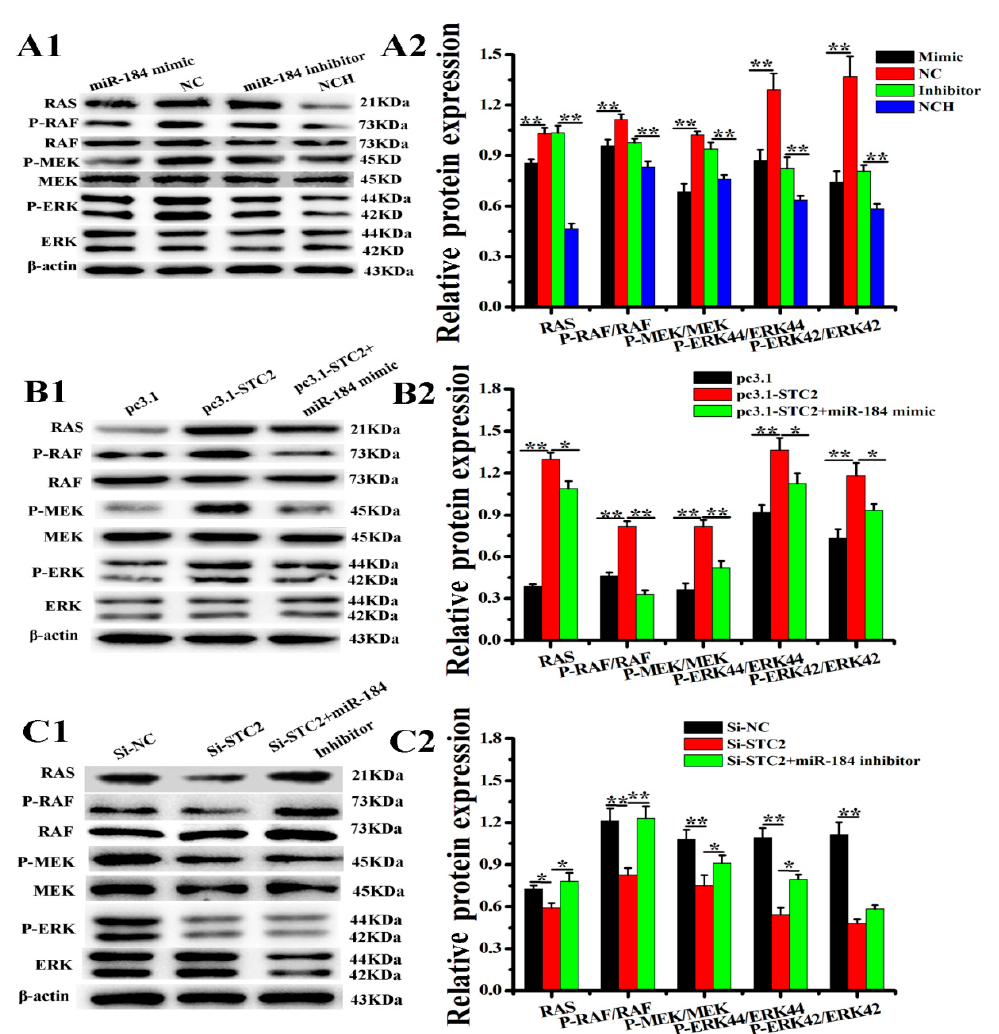
Figure 6 . Effects of miR-184 and STC2 on the RAS/RAF/MEK/ERK pathway. ( A1 , A2 ) WB analysis of RAS, p-RAF, RAF, p-MEK, MEK, p-ERK, and ERK regulated by miR-184. ( B1 , B2 ) After transfection of EECs with pc3.1-STC2 or/and miR-184 mimic, WB was used to detect the expression levels of RAS, p-RAF, RAF, p-MEK, MEK, p-ERK, and ERK at the protein level in EECs. ( C1 , C2 ) After transfection of EECs with Si-STC2 or/and miR-184 inhibitor, WB was used to detect the expression levels of RAS, p-RAF, RAF, p-MEK, MEK, p-ERK, and ERK at the protein level in EECs. The optical density method was normalized to the density of β -actin in the same lane. Data is expressed as the “mean ± SEM” of three values, ** p < 0.01; * p < 0.05. WB, western blot; SEM, standard error of the mean.